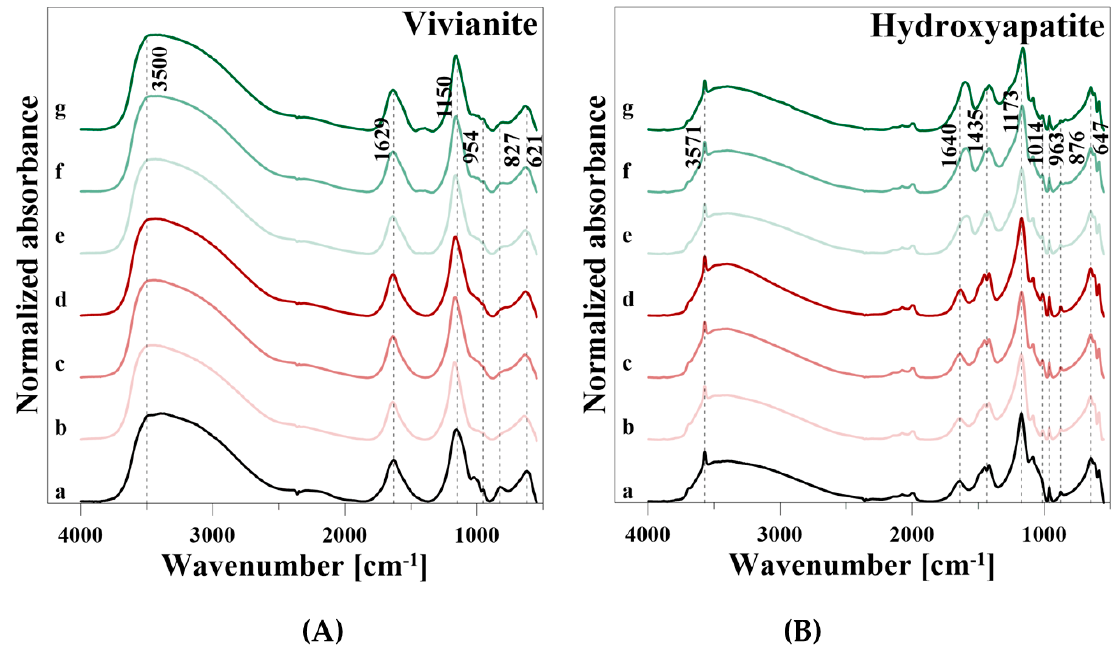
Figure 7. Fourier-transform infrared spectra of ( A ) vivianite and ( B ) hydroxyapatite during P release. (a) reference (b) 0.01 M CaCl 2 , (c) 0.05 M CaCl 2 , (d) 0.1 M CaCl 2 , (e) 0.01 M CA, (f) 0.05 M CA, and (g) 0.1 M CA.